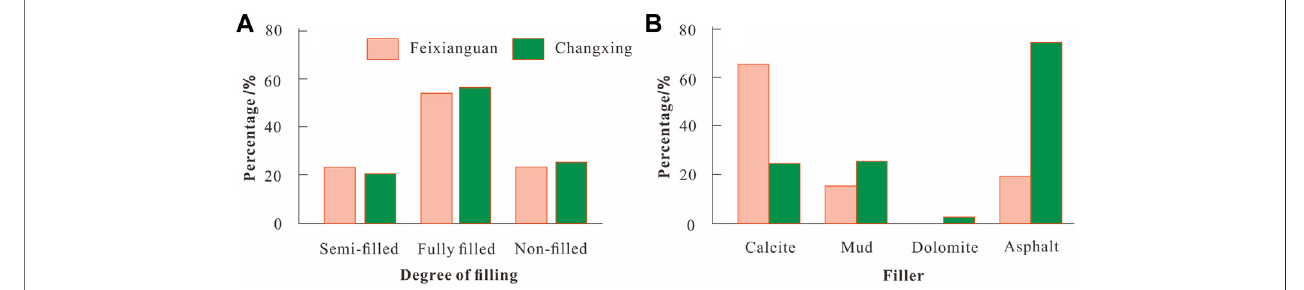
FIGURE 7 | Fracture fi llings of the Yuanba Gas Field. (A) Histogram of the fi lling degree; (B) histogram of the fi lling substance.